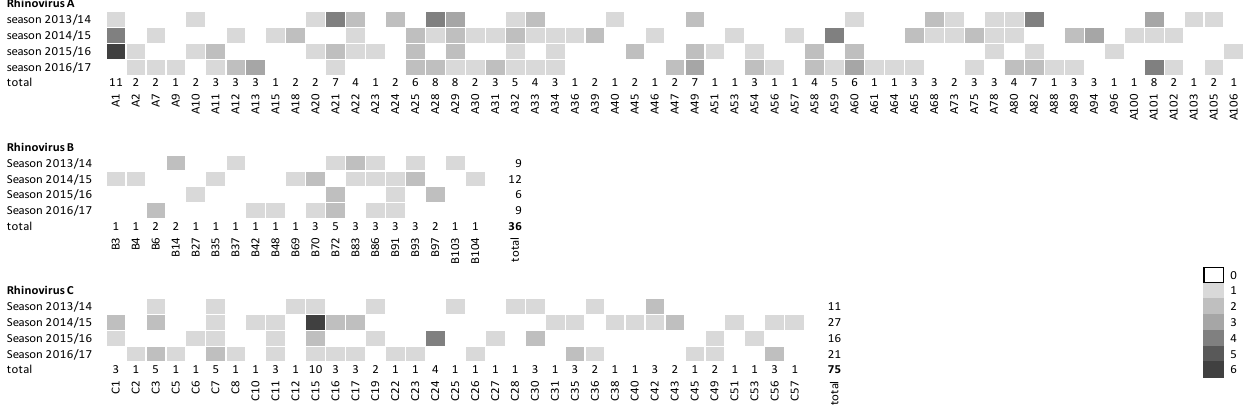
Analyzed categories are displayed on the column to the left and either given as relative and absolute frequencies (% ( n /total)) or ranges (median ± SD). ( n /total) indicates the total amount of cases for the respective season. The brackets indicate parameters that were analyzed in the same contingency table.